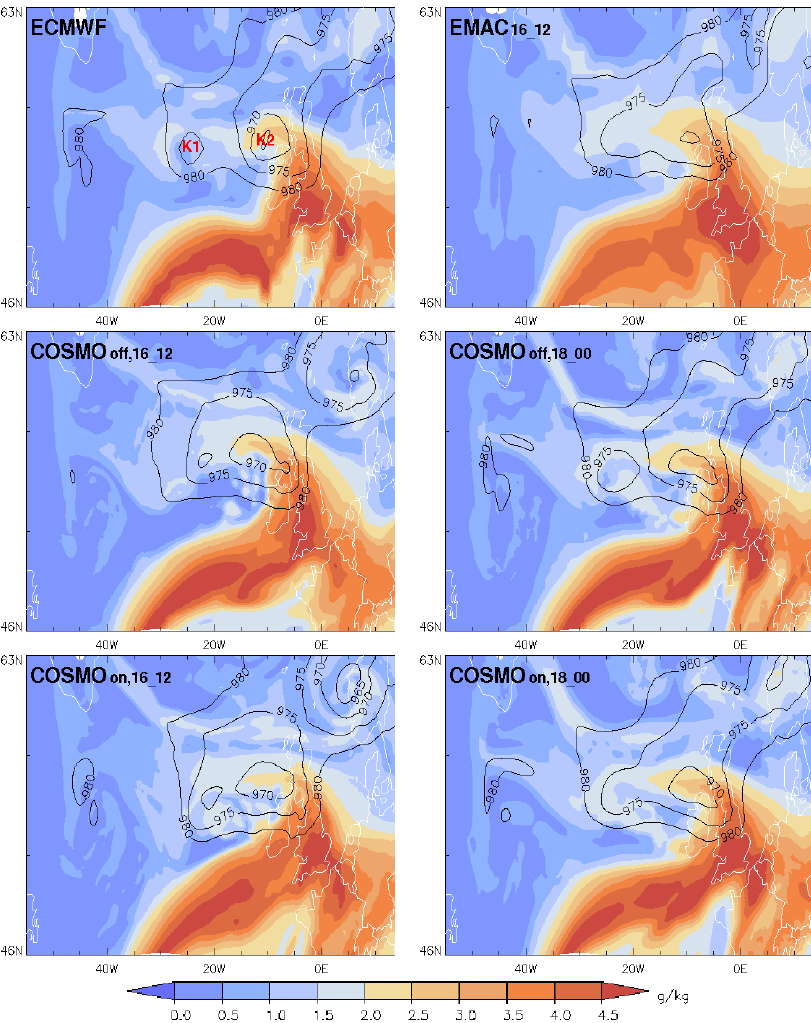
Fig. 12. Specific humidity at 700hPa (colours, in gkg − 1 ), contours of SLP (965, 970, 975, and 980hPa) in the environment of “Kyrill” at 06:00UTC, 18 January for the ECMWF analysis (top left), the EMAC simulations (top right), several COSMO simulations. Both centres of the depression (K1, K2) are marked in the top-left panel.